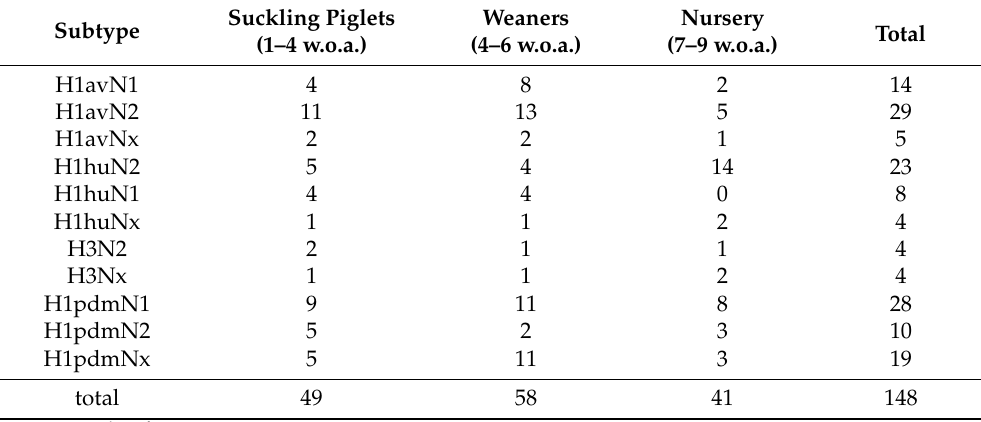
Table 3. IAV Subtypes detected by multiplex RT ‐ PCR in 147 samples with a Ct value < 30 of 749 samples taken from 131 farms.